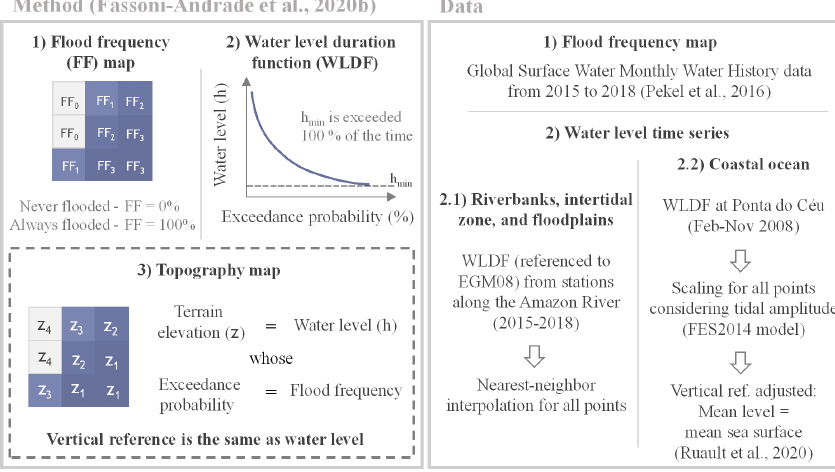
Figure 3. Method to estimate the topography of the water bodies (Fassoni-Andrade et al., 2020b; left panel) and the various datasets considered in this study to implement this method (right panel).